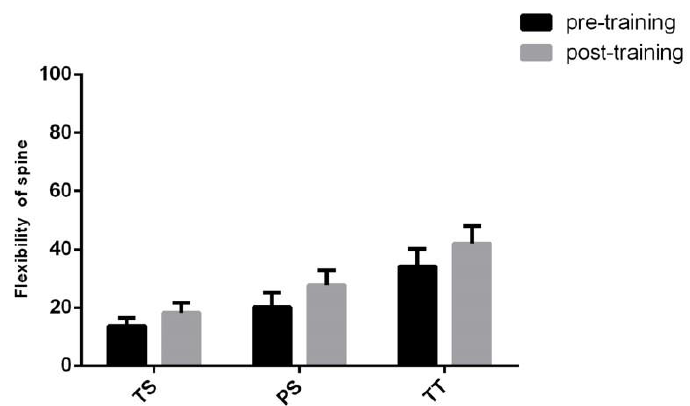
Figure 9. Coxo–femoral mobility test. The results are represented in bar graphs as the mean ± SD of the different phases considered (Turgor Secundus, Proceritas Secunda and Turgor Tertius).